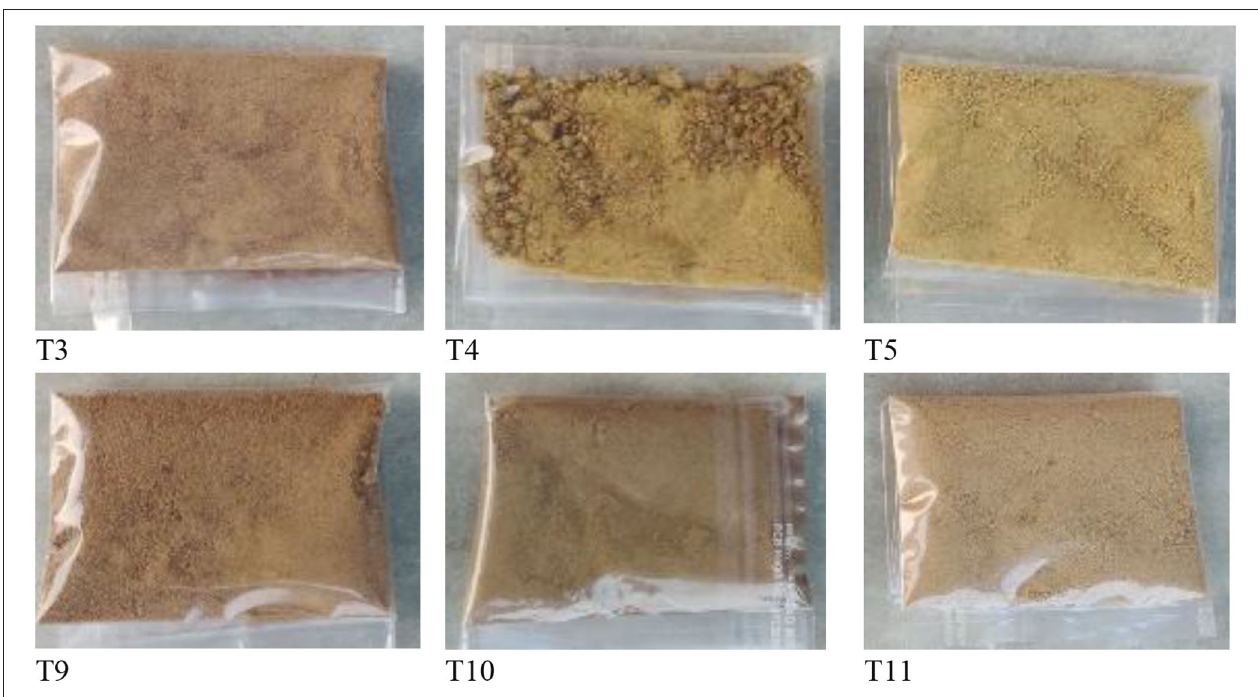
FIGURE 3 | Various forms of pretreated freeze-dried BMP.